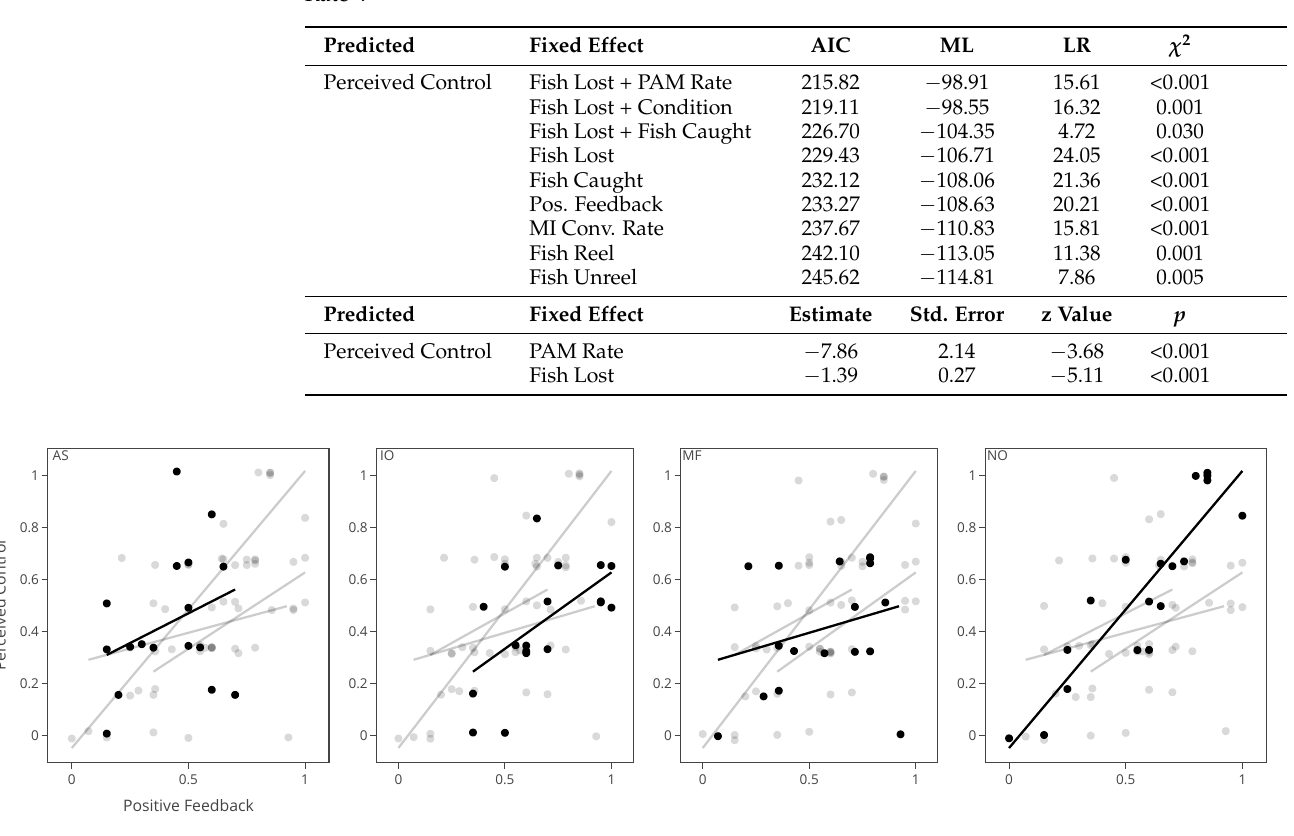
Table 4. (Top) Results of significant likelihood ratio tests predicting perceived control, with the AIC (Akaike information criterion), ML (maximum likelihood), LR (likelihood ratio), and χ 2 (significance). (Bottom) fixed effect estimates for predicting perceived control in the best model “Fish Lost + PAM Rate”.